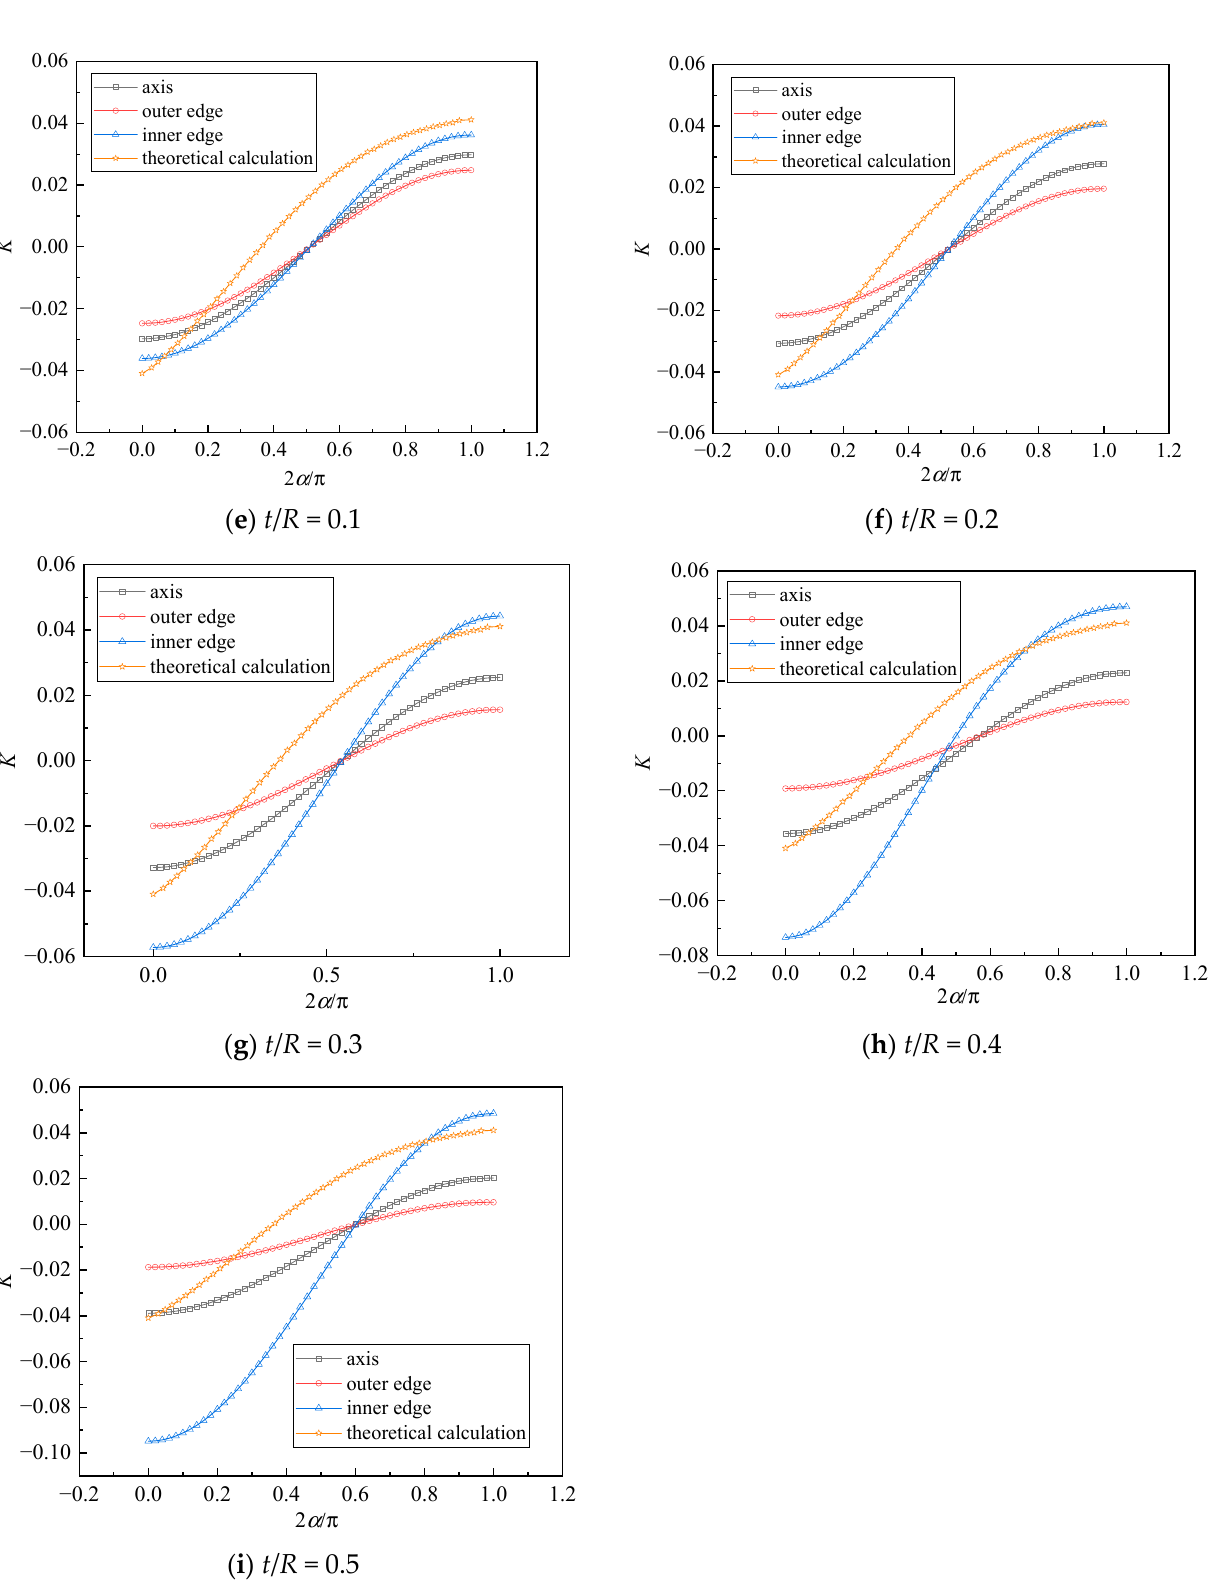
Figure 12. Comparison of numerical simulation results and theoretical calculation results of radial deformation of homogeneous cylinder at different positions under different thickness diameter ratio.